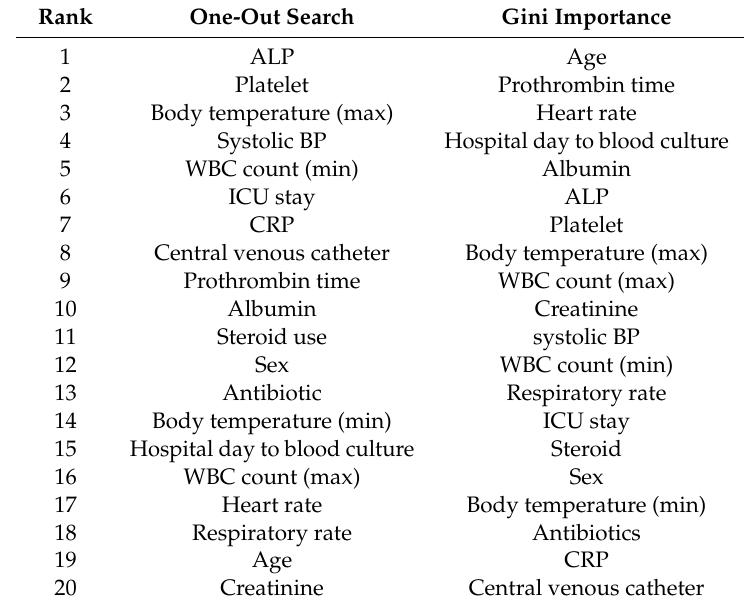
Table 3. Influence of the ranking of the clinical variables on bacteremia predictions. Rank One-Out Search Gini